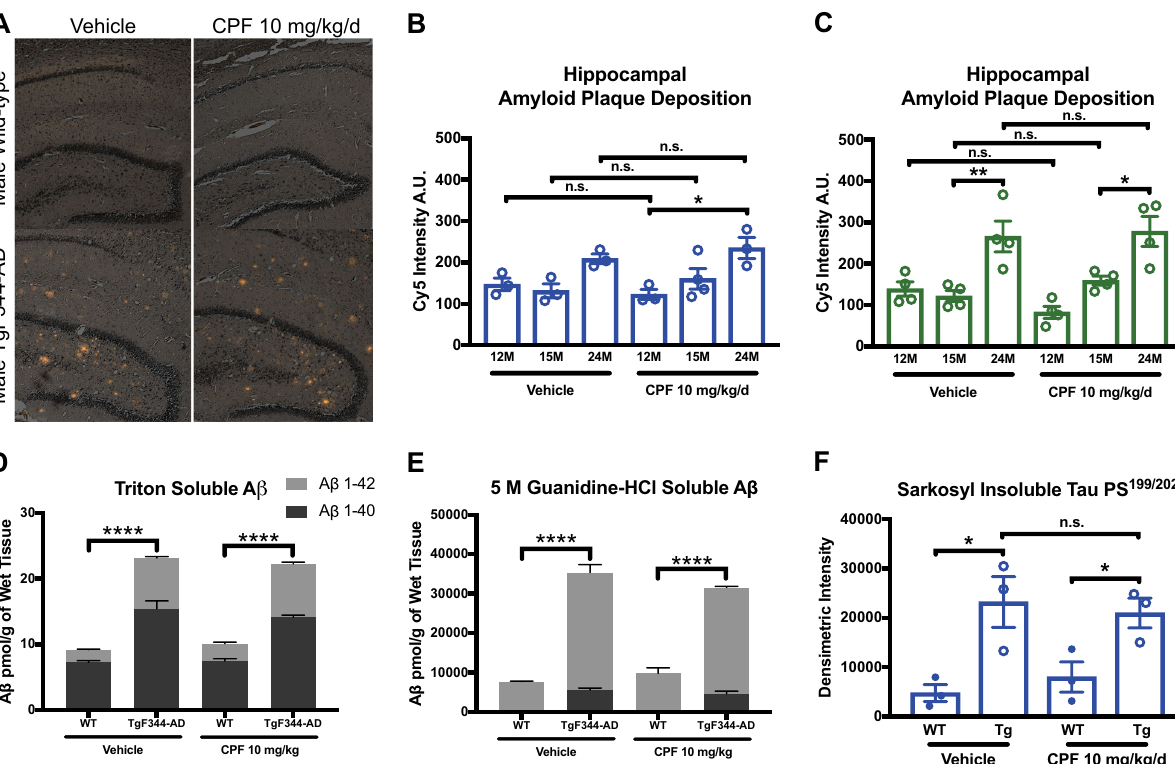
Fig. 5 Amyloid deposition and tauopathy in TgF344-AD rats is unaffected by CPF exposure. a – c Amyloid plaque deposition is signi fi cantly increased in TgF344-AD rats relative to WT rats regardless of CPF treatment. Representative images of Congo red staining in the hippocampus of males are depicted a , and male and female hippocampal plaque deposition in TgF344-AD rats is quanti fi ed using Cy5 intensity measurements b , c . Hippocampal plaque deposition treatment effect: male F 1,13 = 0.4062, P = 0.5350, female F 1,18 = 0.0113, P = 0.9166. Hippocampal plaque deposition genotype effect: male F 1,13 = 11.08, P = 0.0016, female F 1,18 = 25.15, P <0.0001. d , e Soluble (triton) and insoluble (5 M guanidine-HCl soluble) A β 1 – 40 and A β 1 – 42 peptides are elevated in TgF344-AD rats relative to WT animals at 15 months of age regardless of sex or treatment (males presented here). f Pathological tau in the form of hyperphosphorylated insoluble tau is elevated in TgF344-AD rats regardless of sex or treatment (males presented here), as measured by western blot (Figure S7). Total tau protein expression is also elevated in TgF344-AD rats regardless of sex or treatment (presented in Figure S6). Sarkosyl-insoluble abnormally phosphorylated tau protein expression treatment effect for males was F 1,8 = 0.0207, P = 0.8893, while the genotype effect was F 1,8 = 20.68, P = 0.0019. For each measurement, n = 3 – 4/group. Data are represented as mean ± SEM. Signi fi cance was determined using two-way ANOVA with Tukey ’ s post-hoc multiple comparison analysis. * P < 0.05; ** P < 0.01; **** P < were analyzed independently by two blinded scorers, who recorded the time each rat explored each of the objects during the familiarization and choice phases. The percentage of time spent exploring the new object (B) during the choice phase, corrected for any location preference during the familiarization phase, was taken as a measure of memory. Exploration of an object was de fi ned as when the rat directed its nose toward the object at a distance of < 5 cm.